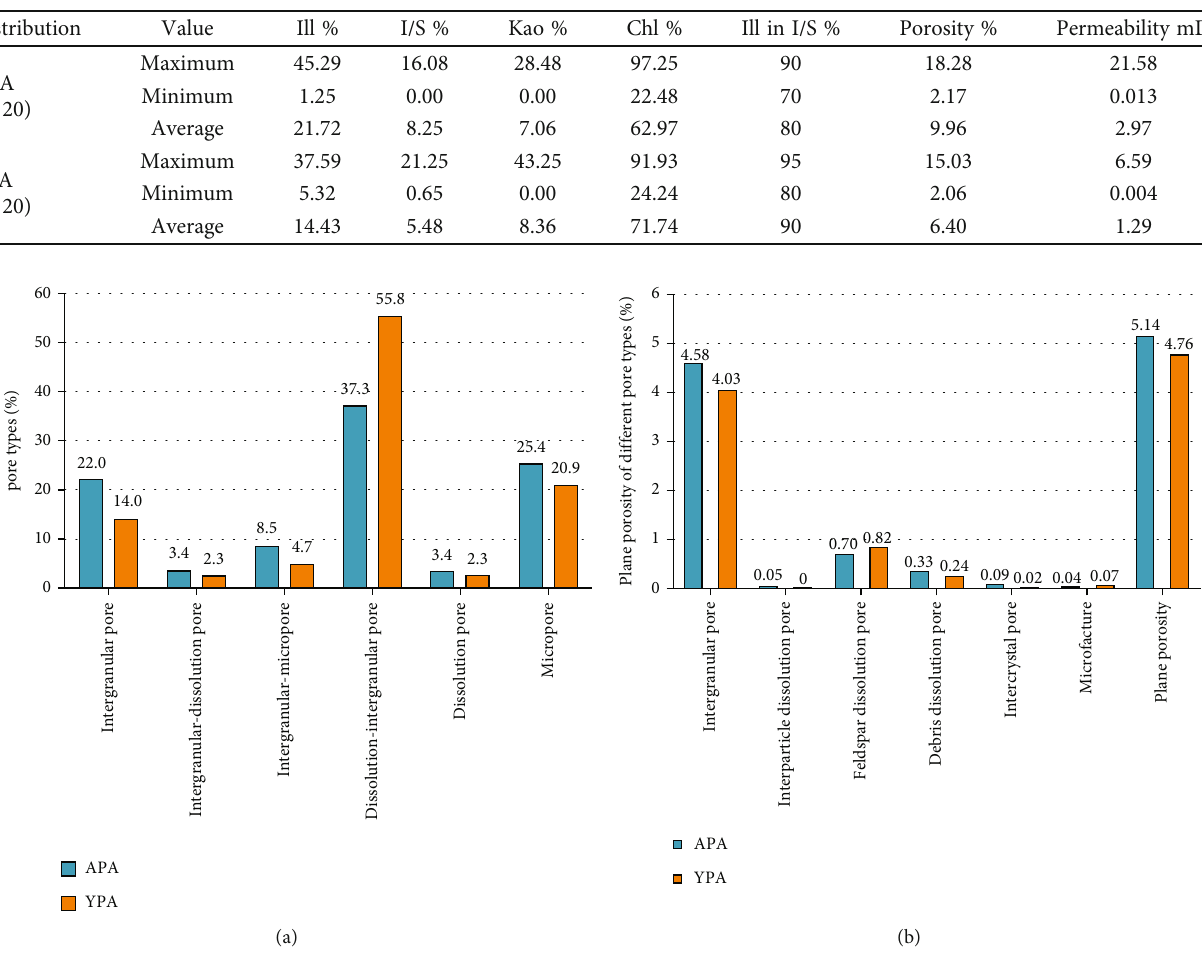
Table 3: Statistical results of XRD in the YPA and APA.